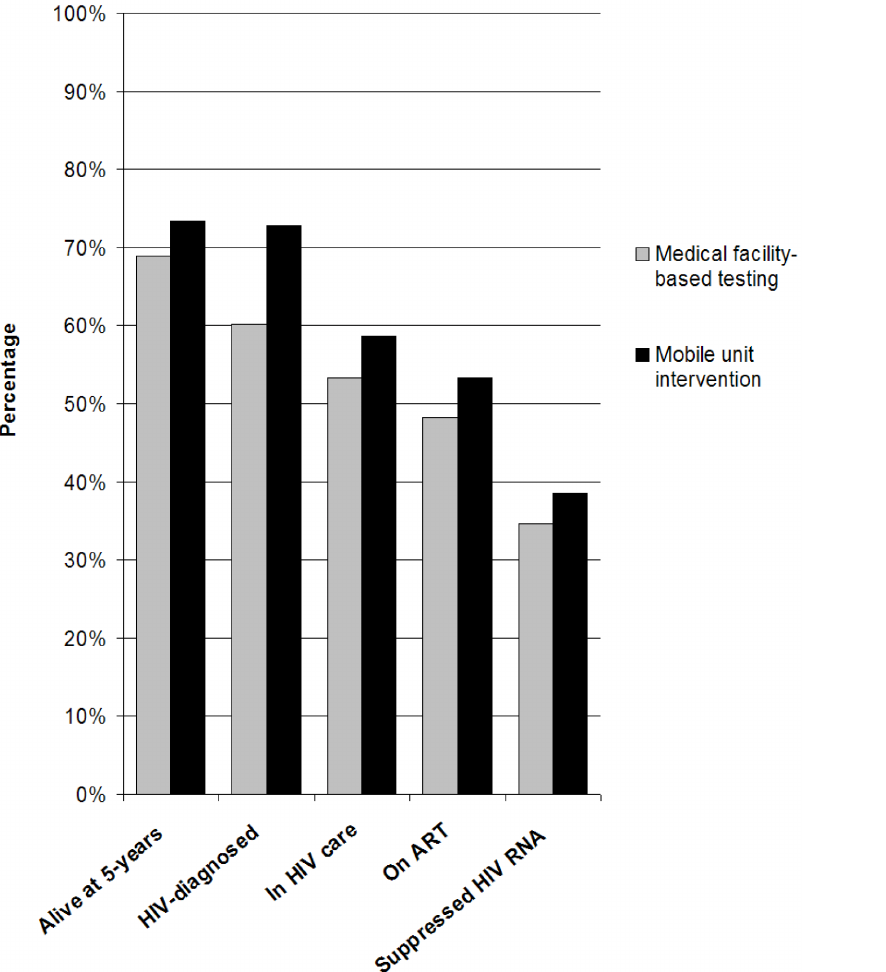
Figure 2. Model-derived survival and engagement in care of HIV-infected individuals in Cape Town at 5 years from the start of observation. The bar graphs shows the proportion (out of the initial 1,240 HIV-infected population) at 5 years who are alive, diagnosed, linked to and retained in care, are on ART, and are HIV RNA suppressed on ART. HIV: human immunodeficiency virus, RNA: ribonucleic acid, ART: antiretroviral therapy.